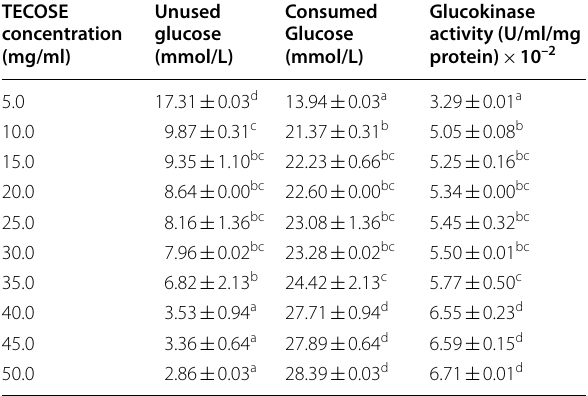
Values are expressed as mean SD ( n 3). Means with different Tukey ± = superscripts along the column are statistically significant at p < 0.05